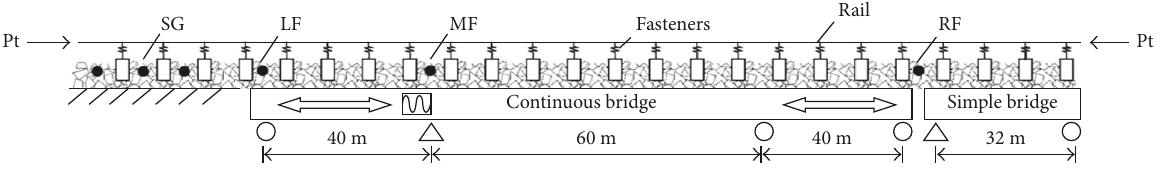
Figure 9: Outline of ballast longitudinal resistance testing.